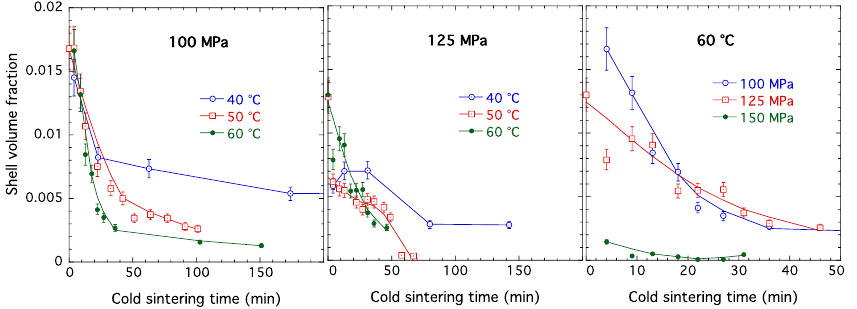
Figure 9. Pore shell thickness versus cold sintering time for 40 °C, 50 °C, 60 °C with p = 100 MPa and 125 MPa, and for p = 100 MPa, 125 MPa, 150 MPa at 60 °C. Logarithmic line fits are guides to the eye.